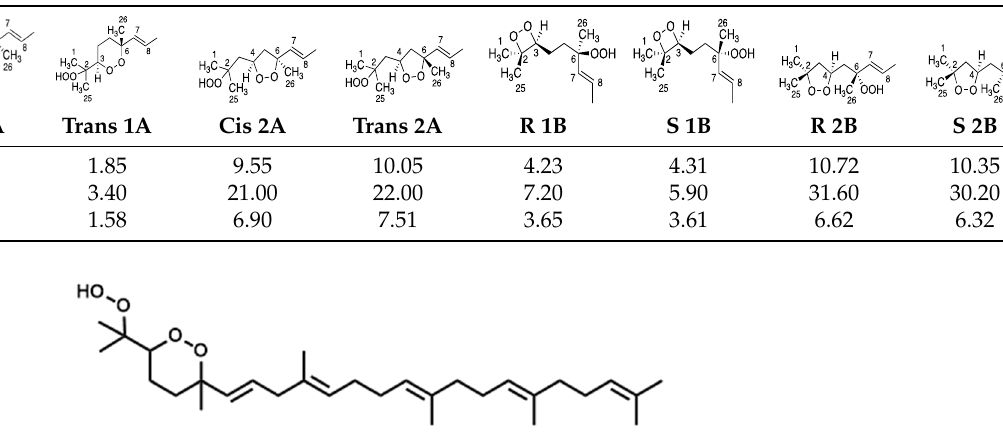
Figure 5. Chemical structure of the newly identified SQ secondary oxidation product, 2 ‐ OOH ‐ 3 ‐ (1,2 ‐ dioxane) ‐ SQ. Table 1. Results of the 13 C chemical shifts calculations carried out on Spartan 18 software.